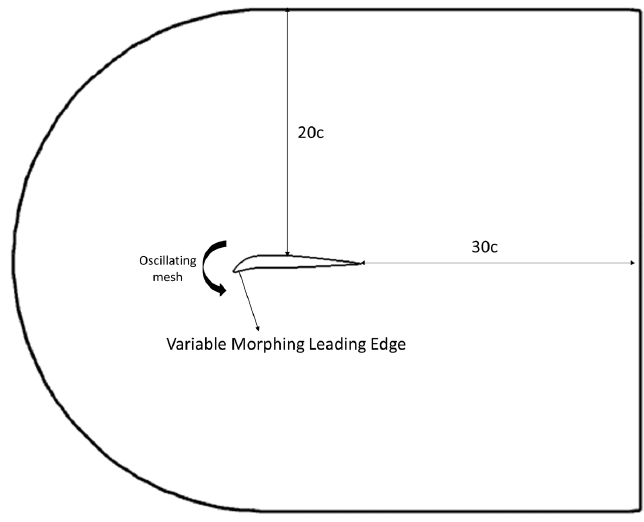
Figure 3. Computational region and boundary